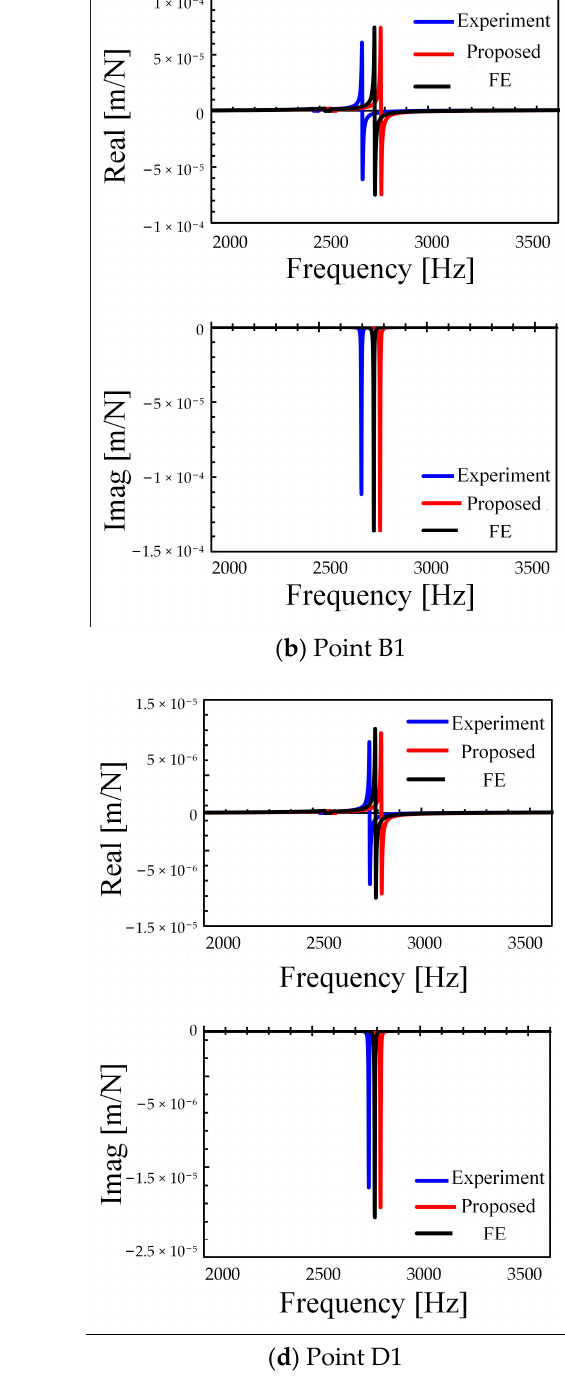
Figure 11. FRFs’ comparison between experiment and prediction.